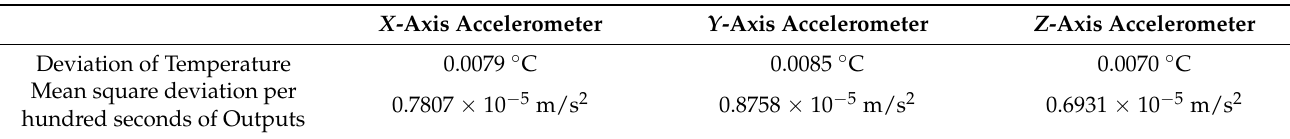
Table 5. The deviation of accelerometer temperature and mean square deviation per hundred seconds of accelerometer outputs in vehicle test.